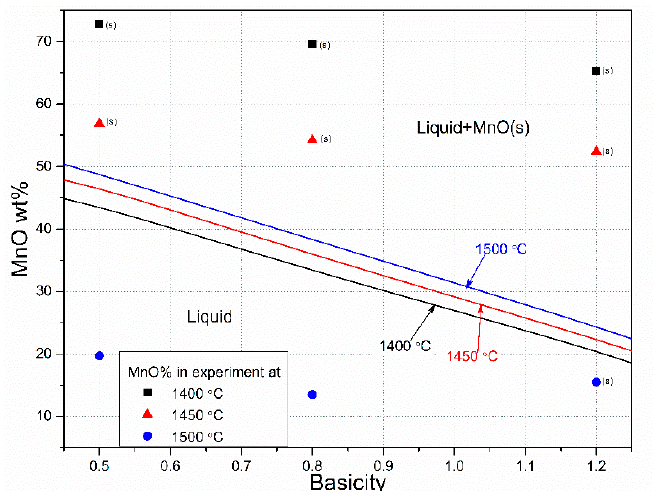
Figure 11. Curves of %MnO of the slag at liquidus temperature, calculated from liquidus relations for MnO–SiO 2 –CaO–Al 2 O 3 (Al 2 O 3 /SiO 2 = 1.24) system in Figure 10. The dots are experimental points, and the (S) marks where spherical MnO phase is observed.